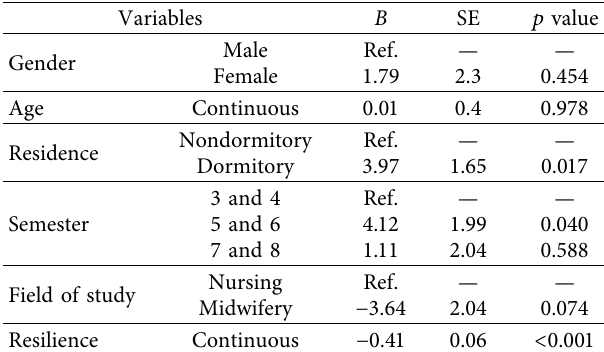
Table 5: Factors related to academic burnout using the regression